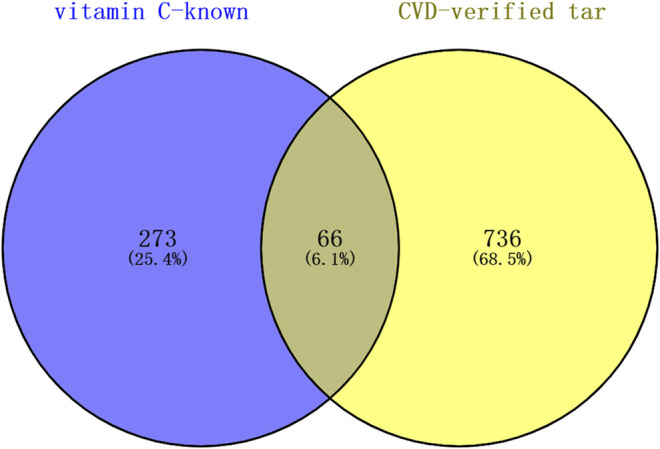
The targets of vitamin C with therapeutic potential for CVD were identified using the Venn diagram. Swiss Target Prediction, DrugBank database, and TCMSP were used to obtain all known targets of vitamin C. DrugBank database, OMIM database, and GeneCards database were used to collect all therapeutic targets for CVD. A total of 66 targets of vitamin C with therapeutic potential for CVD were identified.